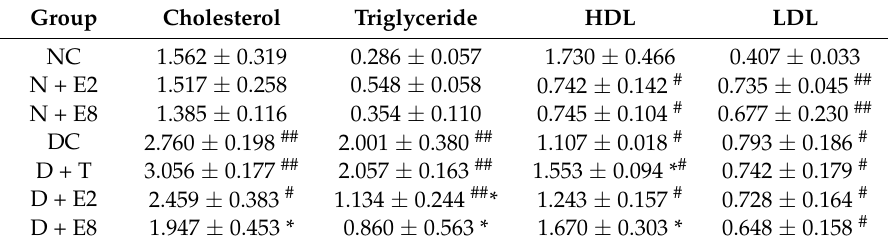
Table 1. Effects of ECE on lipids and lipoprotein of normal and diabetic rats (mmol/L).